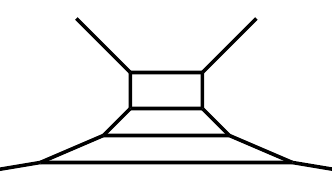
Figure 14 . A toric diagram for Calabi-Yau threefold X obtained by geometric transition from T (cid:3) L (4 ; 1). It can be intepreted as a ( p; q ) brane web relizing e(cid:11)ective 5d N = 2 U(4)